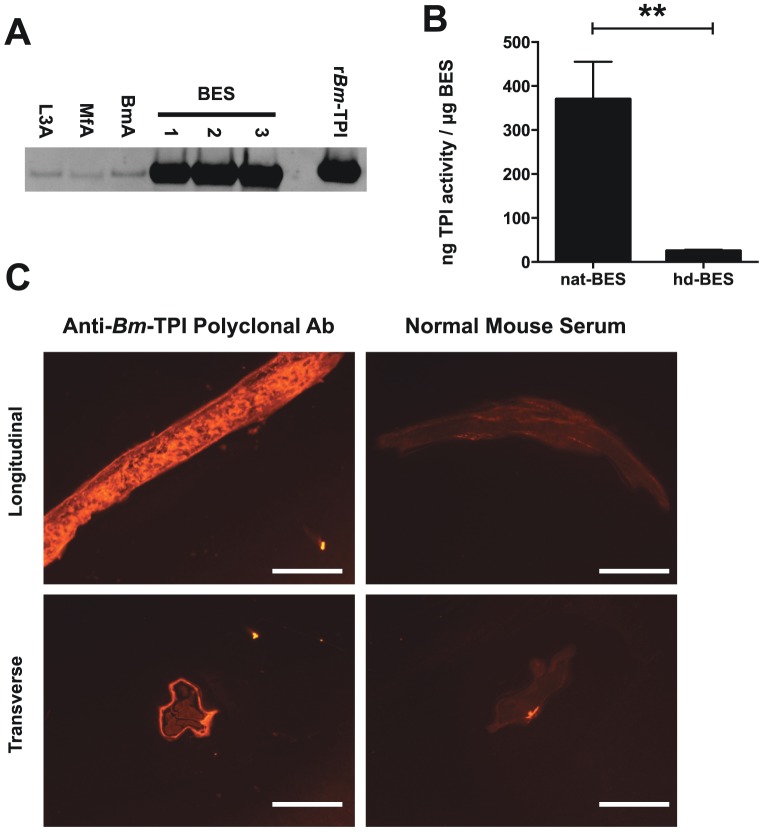
Adult worms preferentially secrete enzymatically active Bm-TPI.
A. Western blot for Bm-TPI of 1 μg parasite extract (somatic extacts of L3 (L3A), Mf (MfA) and adult (BmA) or three independent batches of adult BES. Recombinant Bm-TPI included as a positive control. B. TPI activity in multiple independent batches of native BES or heat-denatured (hd)–BES. ** p<0.01 by t-test. C. Immunofluorescence of adult B. malayi female with polyclonal mouse anti-Bm-TPI (left panels) and control normal mouse serum (right panels) applied to longitudinal (Upper panels) and transverse (lower panels) sections. Scale bar represents 100 μm.